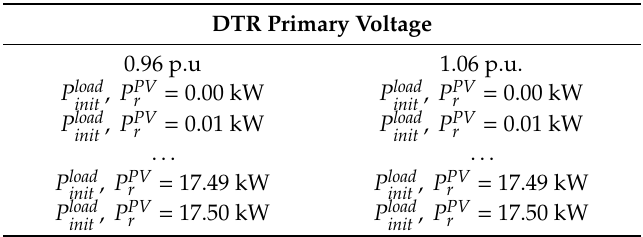
Table 1. Scenarios simulated with each LV test-feeder and control strategy (including no-control).